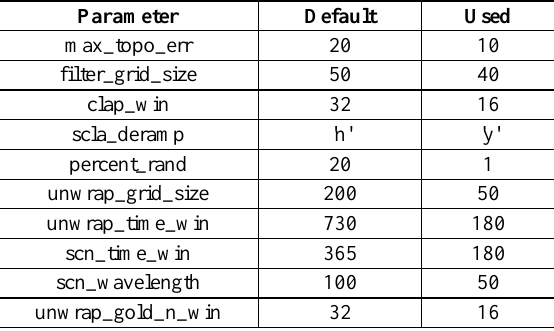
Table 3 . Parameters used for processing